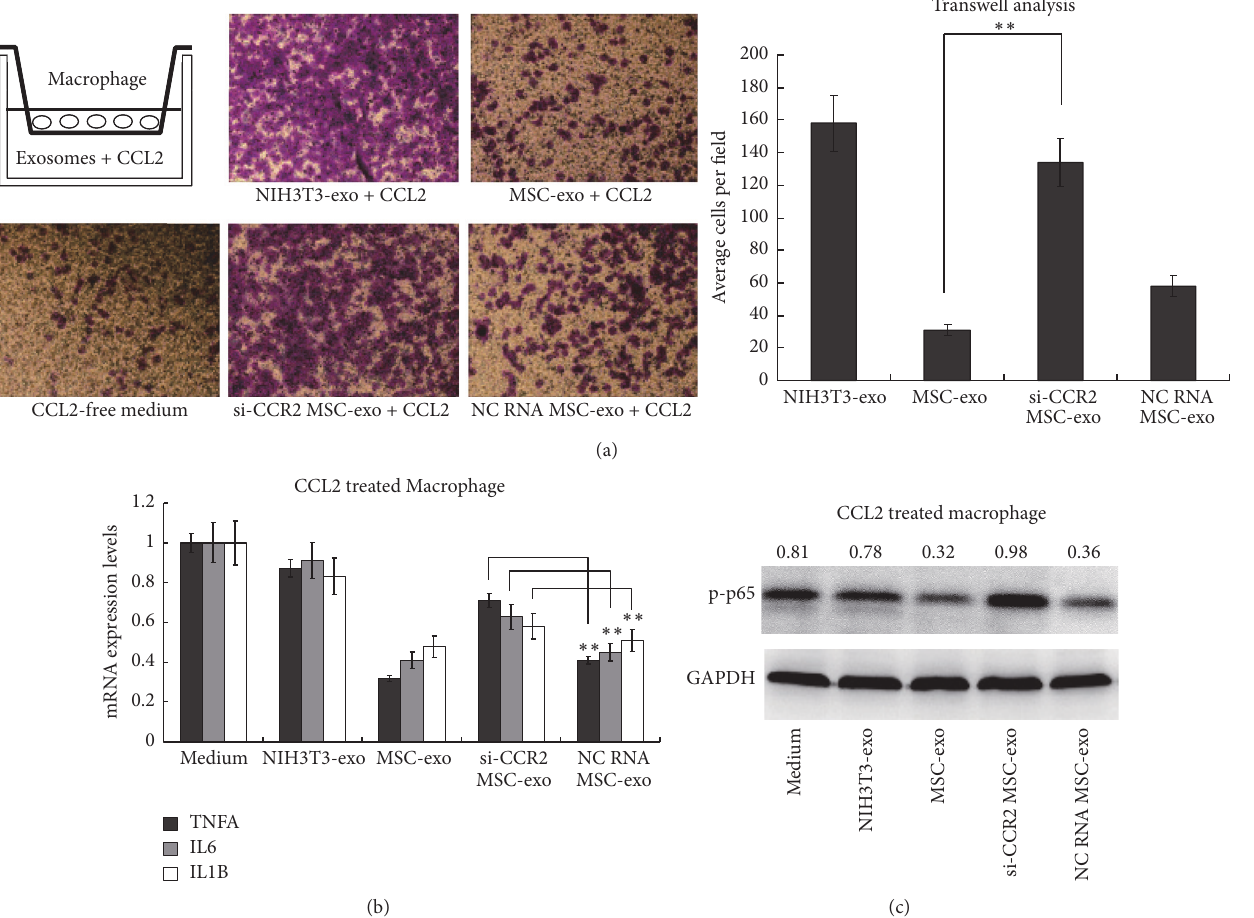
Figure 3: CCR2-positive MSC-derived exosomes suppress macrophage migration and activation. (a) Transwell assay assessing the migration ability of mouse macrophages. The migrated cells on the membranes were counted under the microscope and both the representative figures and averaged cell counts for each group were shown. (b)-(c) Raw264.7 cells were stimulated with CCL2 in the presence of exosomes from the MSCs or NIH3T3 cells. Then, the quantitative RT-PCR analysis was used for the mRNA levels of inflammation factors TNFA , IL6, and IL1B in the macrophages (b). The change folders for each group compared to the CCL2 alone treated macrophages were shown. The WB analysis was used to determine the phosphorylation levels of NF- 𝜅 B p65 (p-p65) with GAPDH as an internal reference protein. The gray levels of blots were analyzed and the ratios of p-p65/GAPDH were shown (c). Exos: exosomes; si-CCR2 MSC-exo: exosomes derived from CCR2 siRNAs- transfected MSCs; NC RNA MSC-exo: exosomes derived from negative control RNA-transfected MSCs; bars represent standard error of the mean ± SD from three repeats. All the significance was determined by ANOVA and Student’s 𝑡 -test. ∗∗ 𝑃 < 0.01